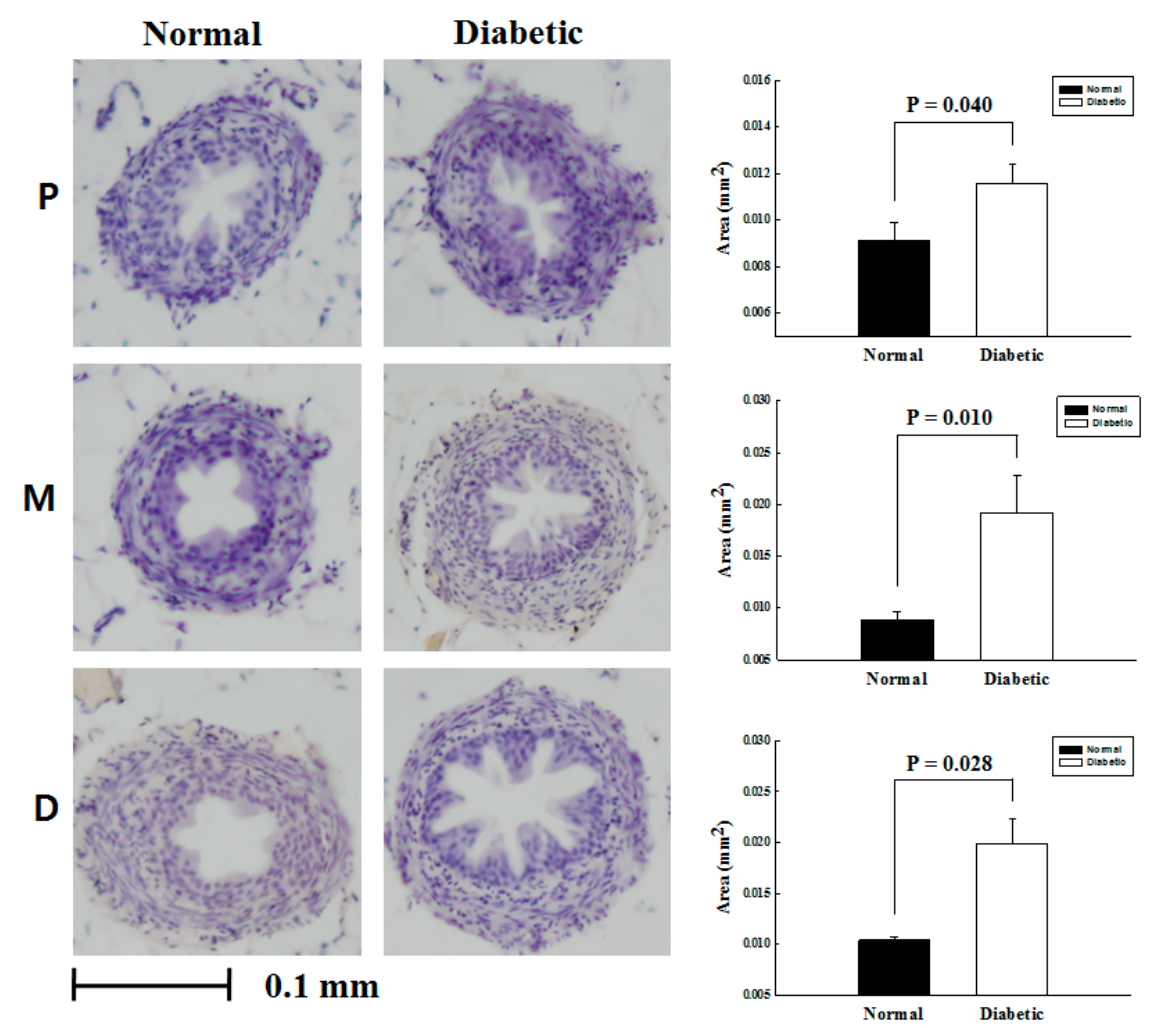
Figure 1. Cross-sectional images of the proximal (P), middle (M), and distal (D) ureter, with comparative graphs of normal and diabetic mouse ureteral smooth muscle thickness.